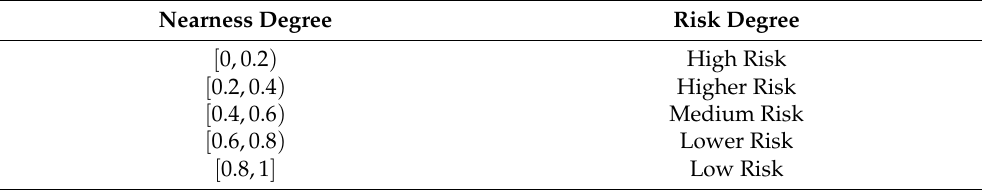
Table 4. Risk zone